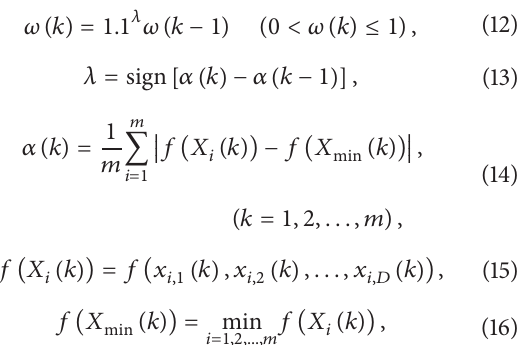
The training steps of PSO algorithm are described as